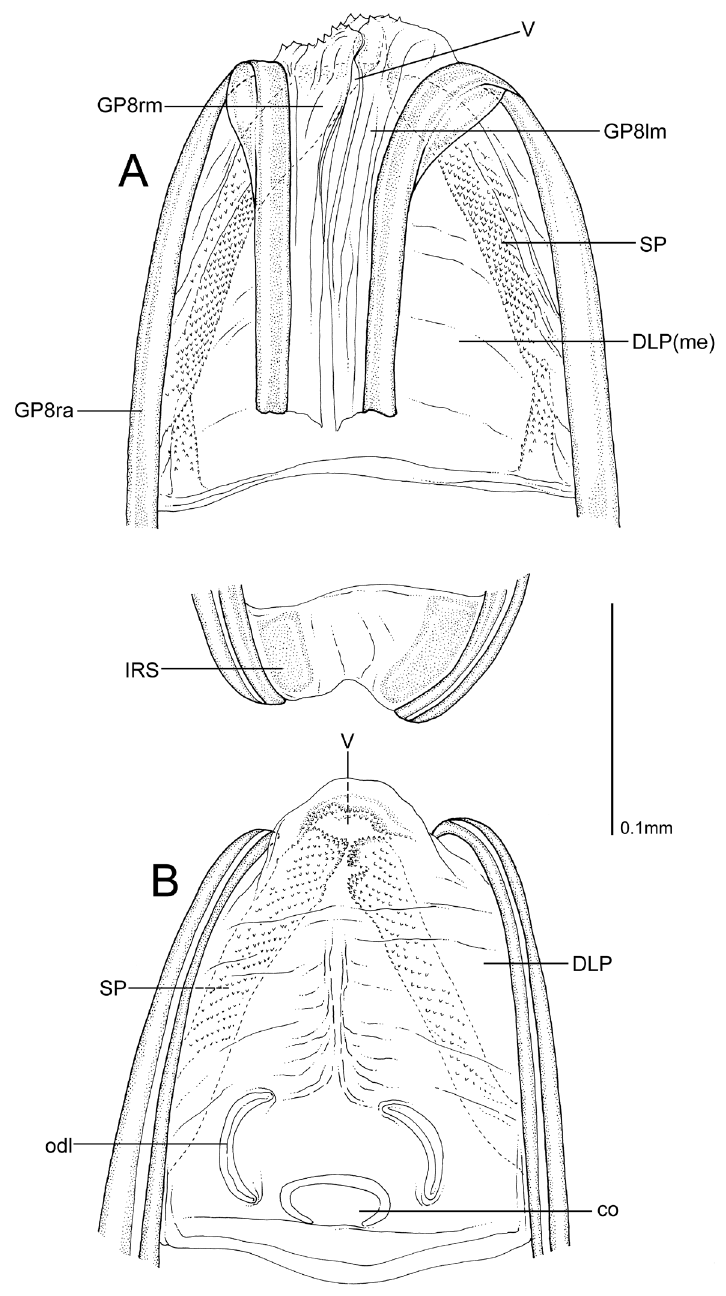
Figure 4. Female genitalia of Henryhalticus philippinensis gen. et sp. n. A Ventral view of external female genitalia, including posterior wall of bursa copulatrix B Dorsal view of external female genitalia. Abbre- viations: co = common oviduct; DLP(me) = dorsal labiate plate, mesial surface; GP8lm = gonapophyses 8 basal left membrane; GP8rm = gonapophyses 8 basal right membrane; IRS = inter-ramal sclerite; odl = lateral oviduct; SP = spiculate area of mesial surface of dorsal labiate plate; V =